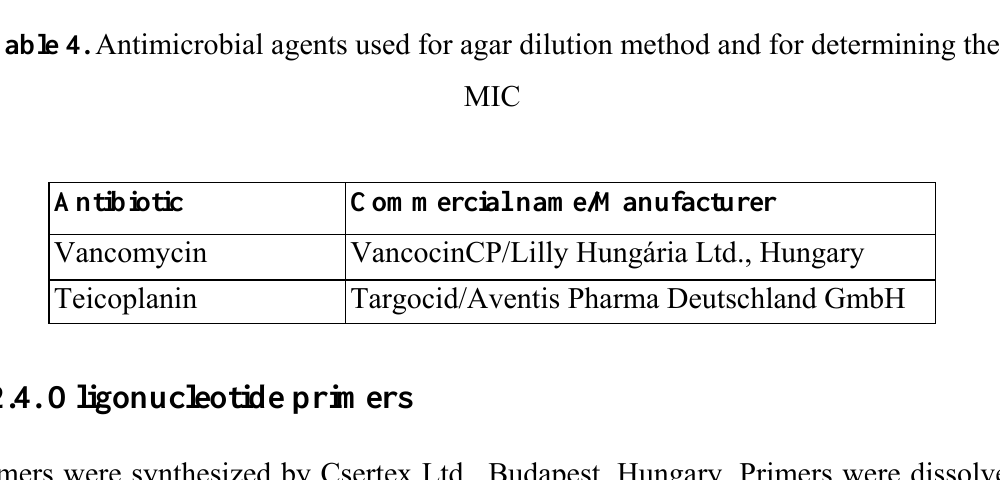
Table 4. Antimicrobial agents used for agar dilution method and for determining